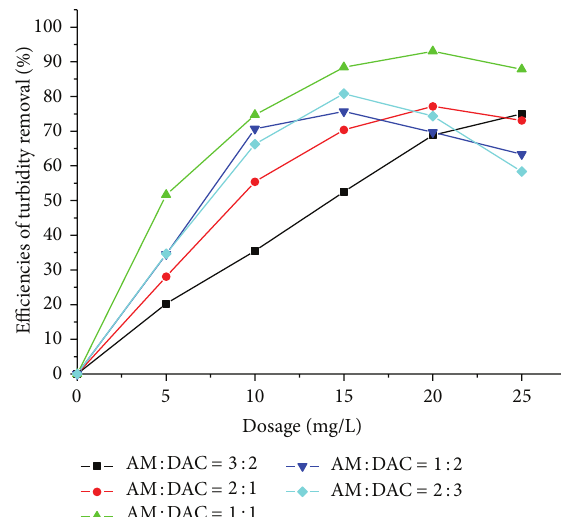
Figure 15: Effects of ratio of monomers on turbidity removal for sewage.